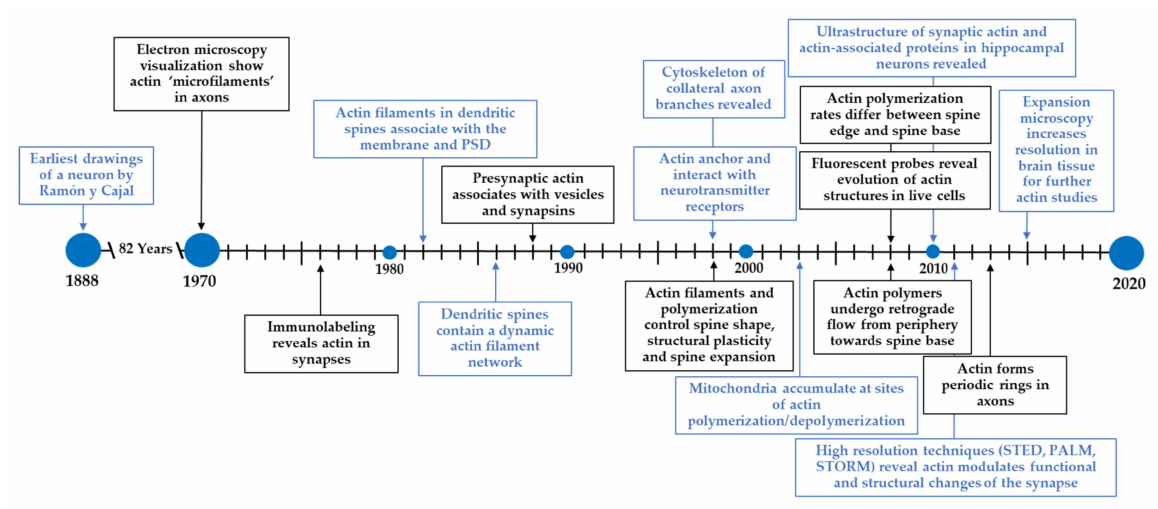
Figure 1. Timeline for the discovery and study of actin at the synapse. Ram ó n y Cajal pioneered modern-day neuroscience by identifying neurons and dendritic spines. Since then, new technologies have expanded our understanding of neurons and its underlying components. In particular, the field has made tremendous progress in understanding the structure and functions of the actin cytoskeleton in